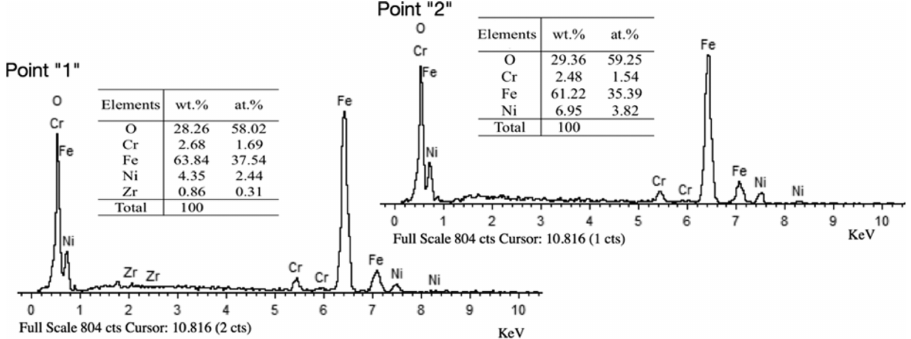
Figure 12: Energy dispersive X-ray spectrometry of the points marked “ 1 ” and “ 2 ” in Figure